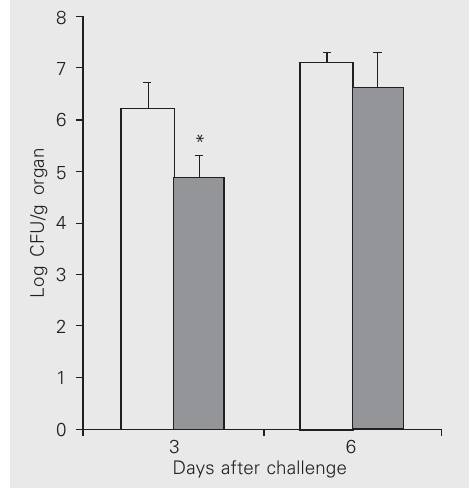
Figure 5. Translocation of Sal- monella Typhimurium to the spleens of control (open col- umns) and experimental (filled columns) gnotobiotic mice. Germ-free mice received PBS (control) orally or Escherichia coli EMO strain (experimental) 10 days before challenge. The fig- ure represents one of two simi- lar results. Three mice were used per group on each day. CFU = colony forming